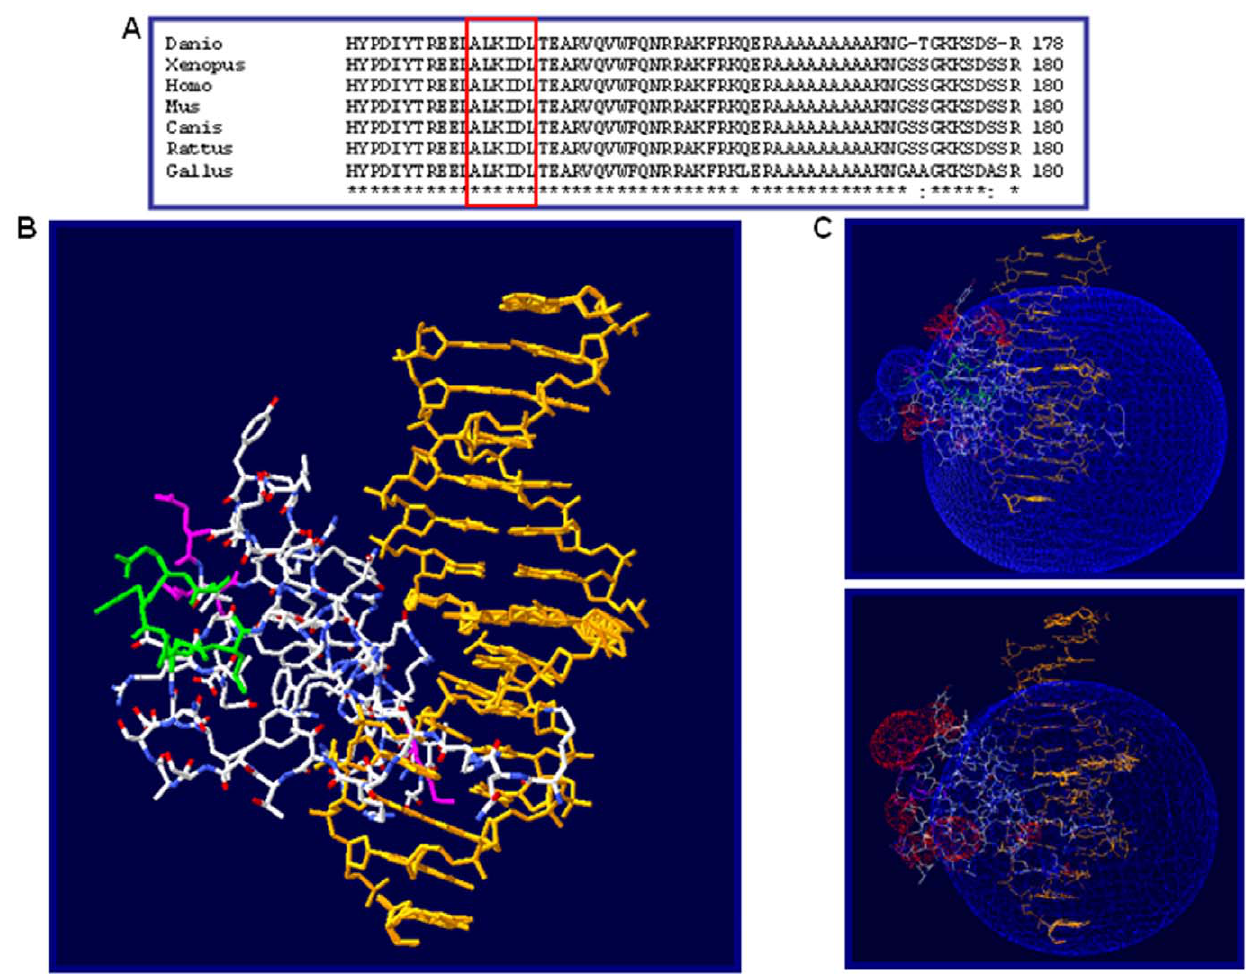
Figure 2. Structure of the homeodomain. (A) Multiple sequence alignment among different species. Aminoacid residues involved in the deletion are included within a red box. (B) Three-dimensional representation of the interaction between the Drosophila sp. homeodomain and the target DNA sequence (orange). Aminoacids encompassed by the deletion are represented in green. C) Prediction of the electrostatic potential for the wild type protein (up) and the mutated one (down). Negative charge is represented in blue and positive charge in